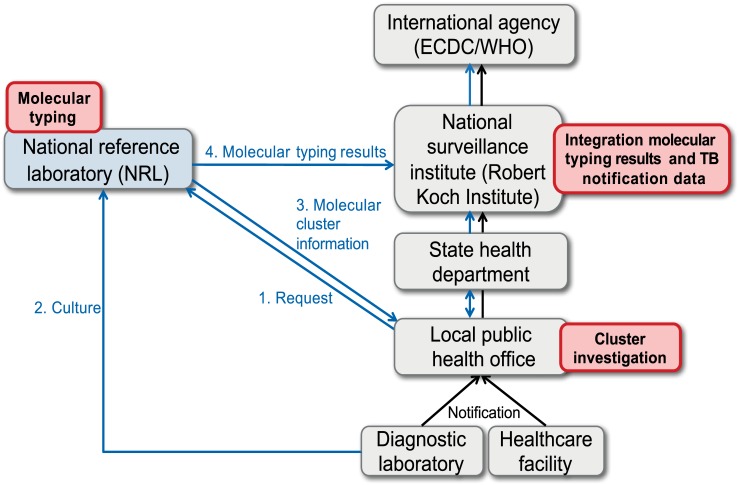
Pilot data flow of the molecular typing results in Baden Württemberg (Germany).1. Molecular typing requested by local public health offices to NRL; 2. Culture shipment to NRL; 3. Communication of molecular cluster information from NRL to local public health offices and 4. Communication of full molecular typing results from NRL to RKI.